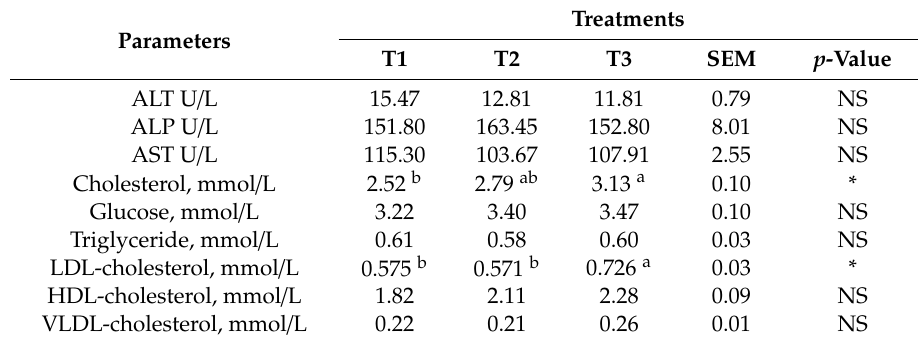
Table 7. E ff ect of PKC-urea treated rice straw supplemented with di ff erent levels of corn on the biochemical blood parameters in